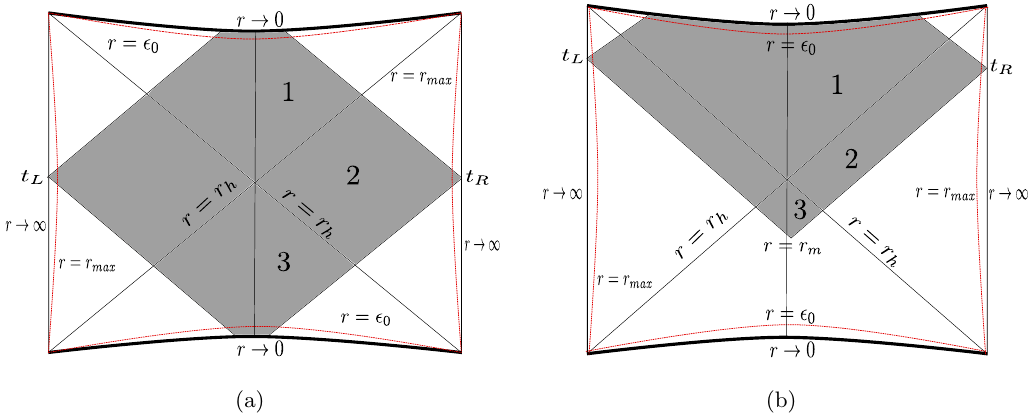
Figure 1 . Panel (a) shows the Penrose diagram at time t < t c and panel (b) shows the diagram at t > t c